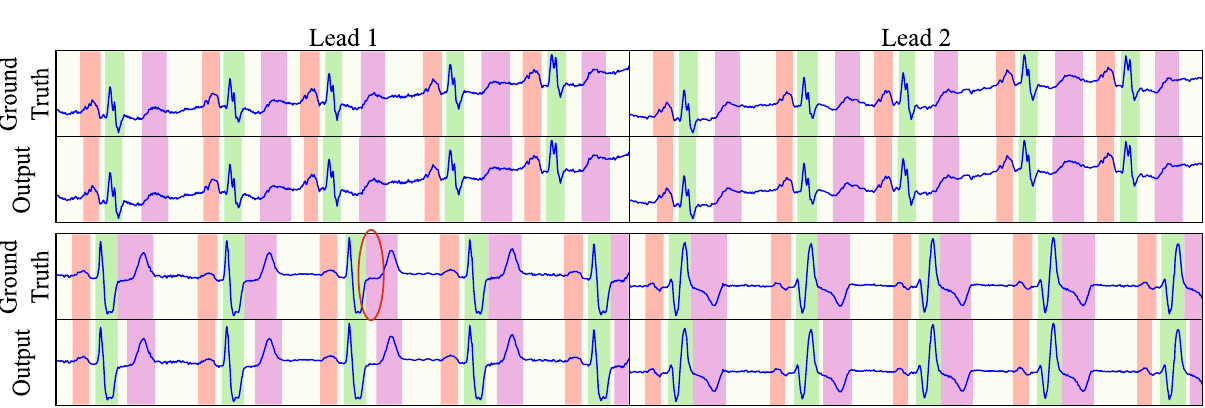
Figure 5. Examples of correctly predicted samples, depicting samples from sudden cardiac death (top) and ST change (bottom). Red mask: P wave. Green mask: QRS wave. Magenta mask: T wave. Representative examples have been